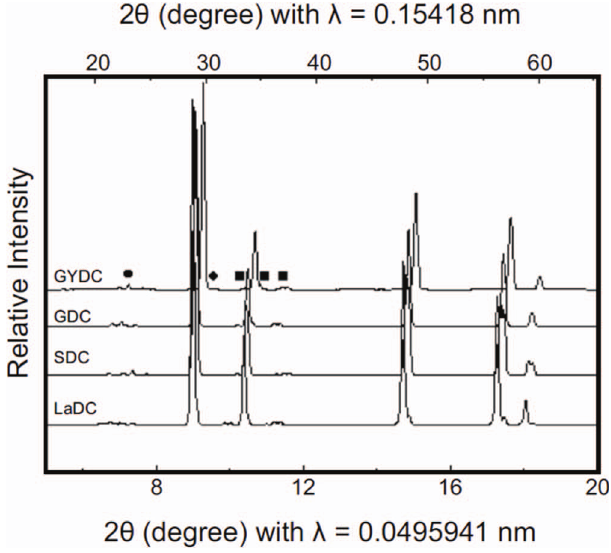
Fig. 4. XRD diagram of the RDC series composites. The angle of diffraction 2 h values are for X -wavelength 0.15418 nm (top) and 0.0495941 nm (bottom). The symbol ( d ) in the diagram indicates the Li 2 CO 3 signal, whereas ( & ) indicates the Na 2 CO 3 signal.